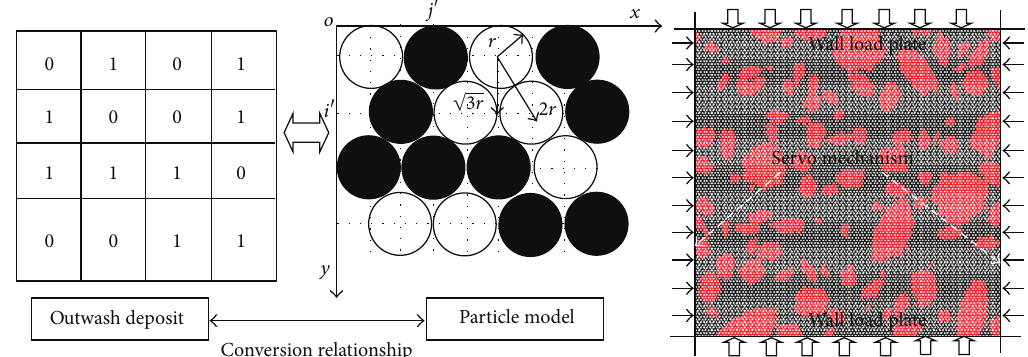
Figure 6: Construction of a debris-stone micromodel using a spot matrix and PFC2D.